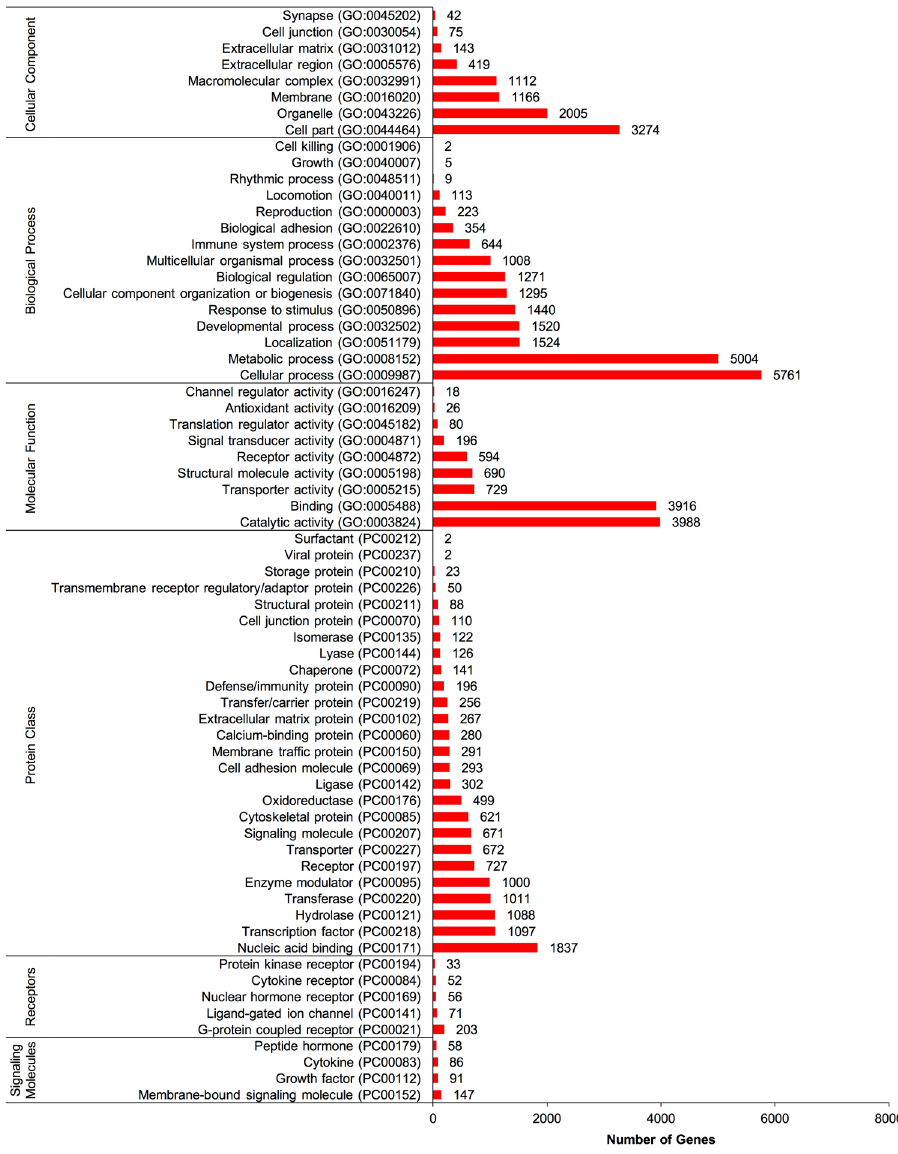
Figure 2. Gene ontology (GO) classification of assembled Carassius auratus RGC genes into molecular function, biological function, cellular component, protein class, receptor and signaling molecule categories. The number of genes ascribed to each classification is provided along with GO or protein class (PC) accession